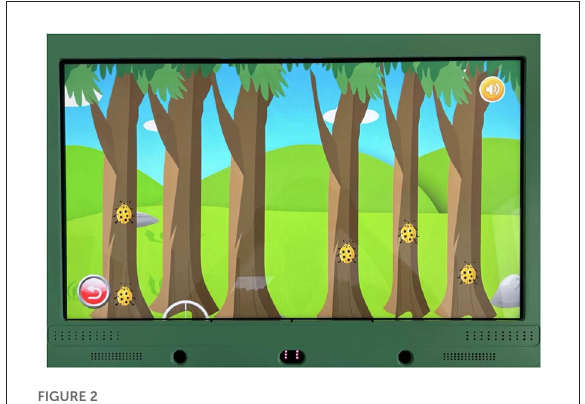
FIGURE2 Eye movement training device (image from